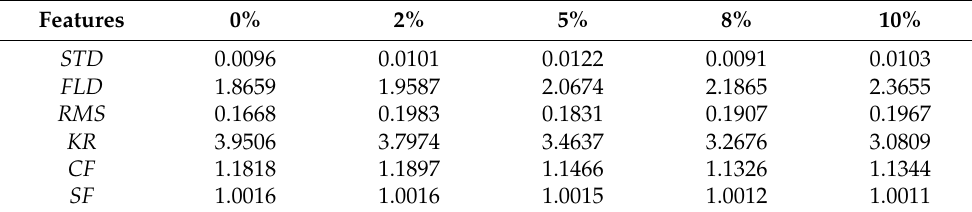
Table 1. Features of the surge velocity signal in the time domain for different fault severity.